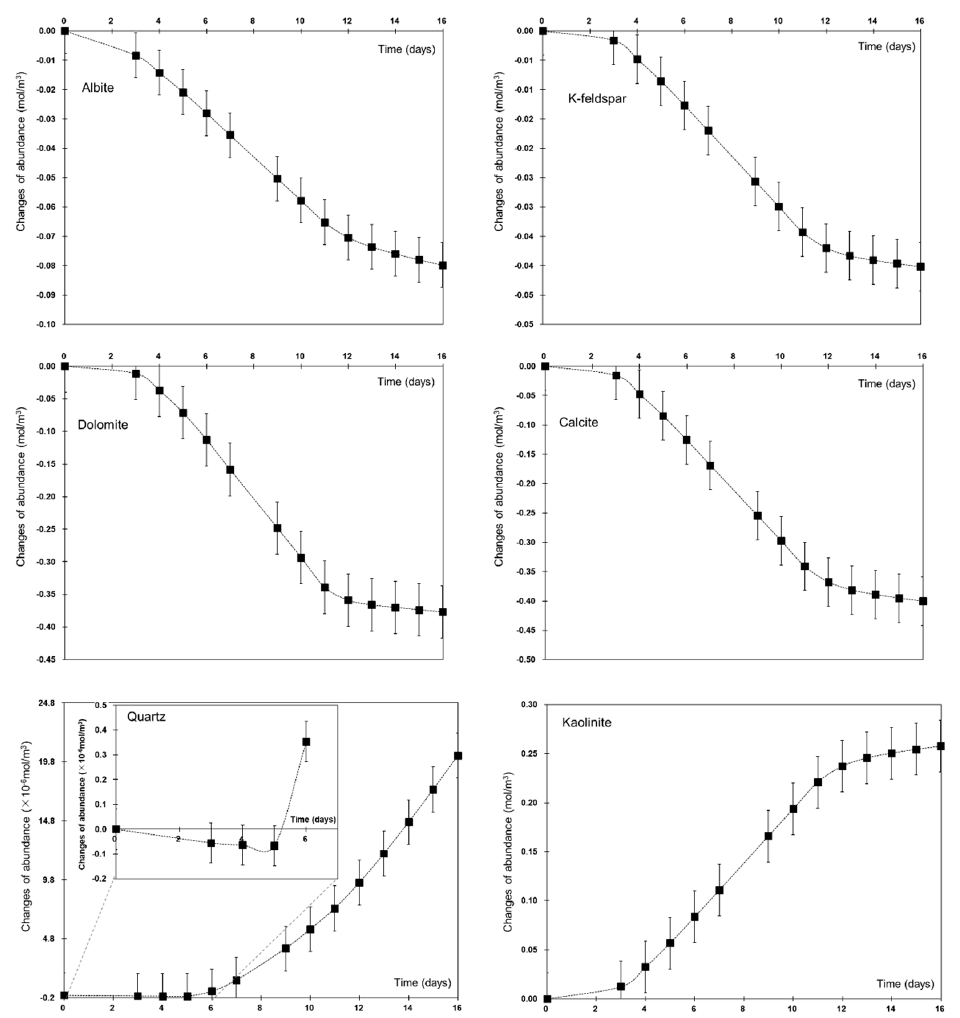
Figure 7. Mineral changes over time in the numerical simulation.